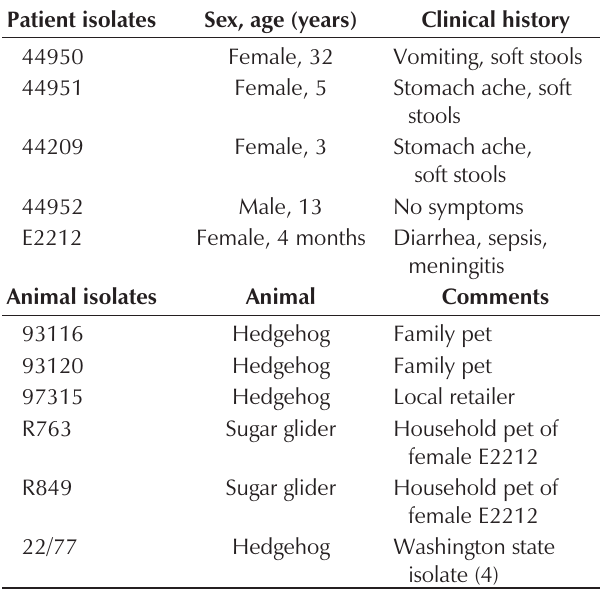
Origin of isolates, patient demographics and clinical